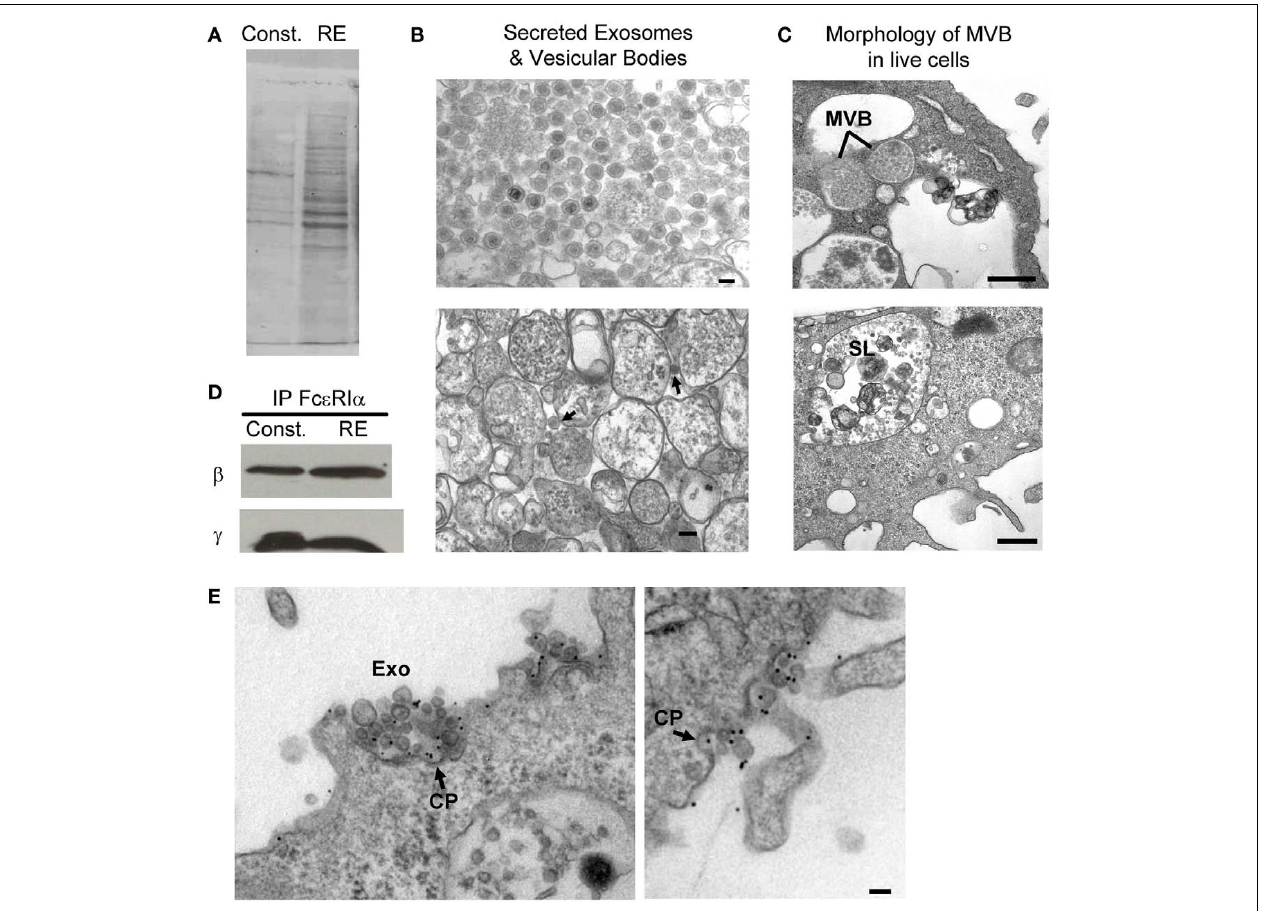
by blotting for β and γ demonstrate the subunits exist in a complexed state. (E) Exosomes with intact, IgE-bound receptors bind antigen and mediate reuptake of exosome-antigen complexes in coated pits. RepresentativeTEM images of RBL-2H3 cells primed with α -DNP IgE and stimulated with DNP–BSA-colloidal gold showing that gold-conjugated ligands target both the plasma membrane and exosome-associated Fc ε RI. The presence of multiple exosomes within coated pits (denoted with arrows labeled CP) shows reabsorption of exosomes with crosslinked receptor. Scale bars = 0.1 μ